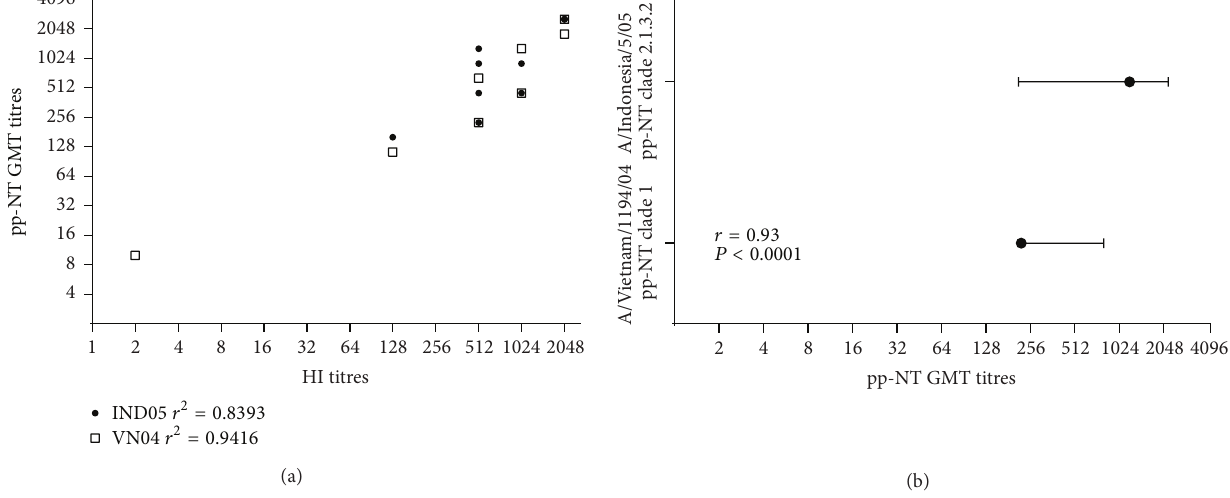
Figure 5: (a) Comparison of pp-NT with HI titers. Scatterplots showing the correlation of antibody logarithmic titers measured by pp-NT versus HI. For the pp-NT assay, HPAI H5 from A/Vietnam/1194/04 VN04 and A/Indonesia/5/05 (IND05) were tested. Pearson’s correlation analysis was carried out and the coefficient of determination ( 𝑟 2 ) for each strain reported on the graph. (b) Paired 𝑡 -test performed by using